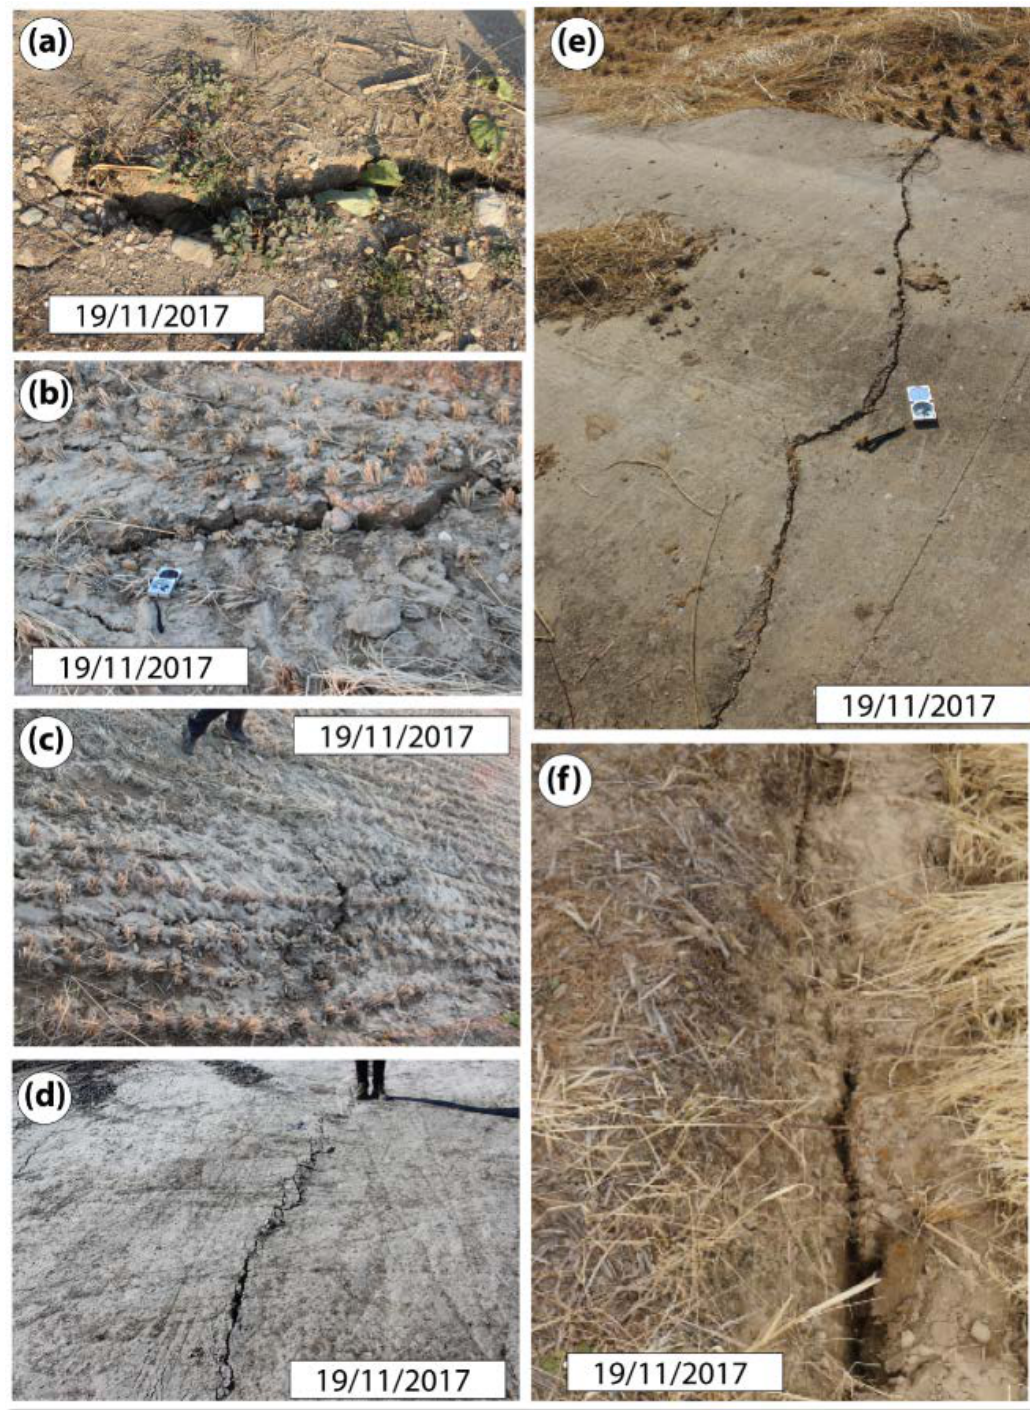
Figure 5. Field photos showing the observed ground cracks during the 2017 Pohang earthquake; ( a ) observed ground crack along the embankment of rice field around Yongjeon-ri; ( b – d ) ground cracks observed near Hangdong University. The ground cracks were around several meters in length, with a few centimeters to more than 20-cm vertical displacement; ( e ) crack 2–7-cm wide observed along a concrete road near Mangcheon-ri; ( f ) observed ground cracks in the rice farm around